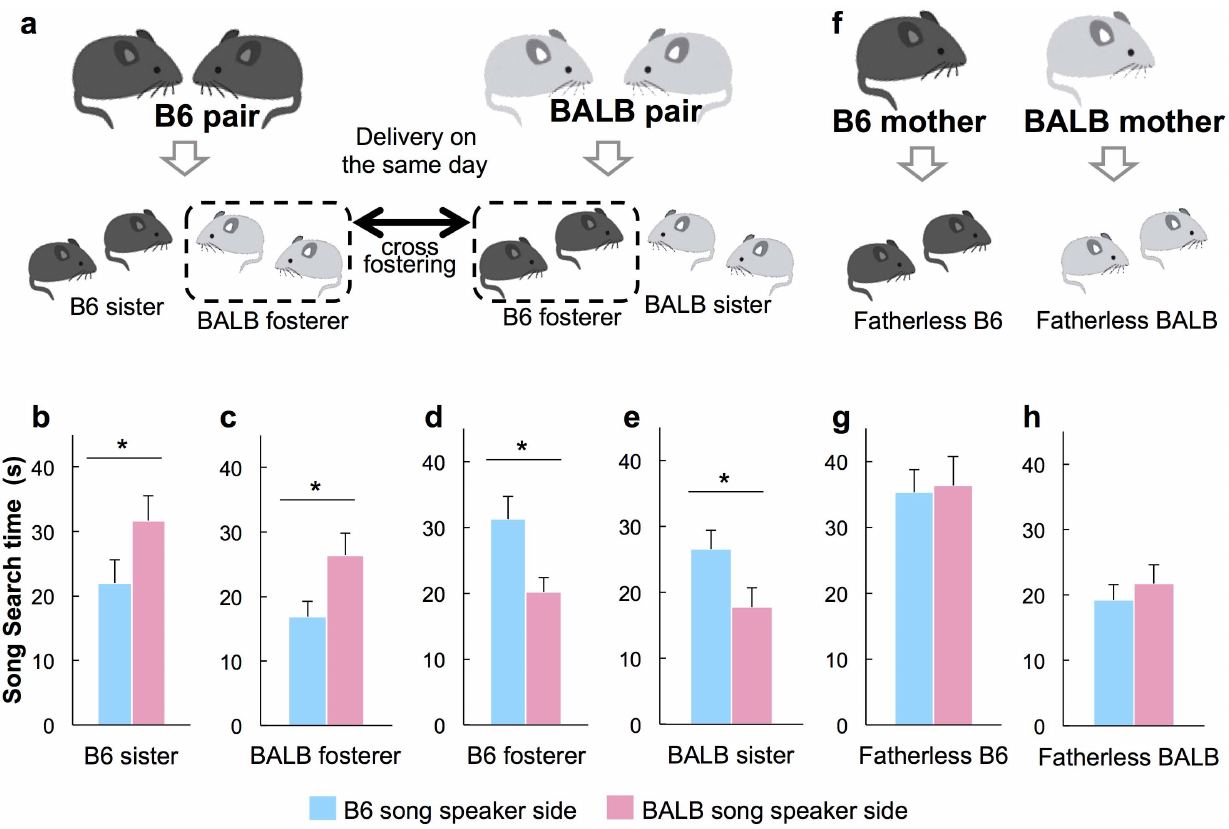
Figure 4. Cross-fostering reversed, and fatherless rearing diminished, female song preference. ( a ) Experimental scheme of the cross- fostering paradigm. Part of the litter (B6-fosterer and BALB-fosterer) was reciprocally cross-fostered to parents of the other strain of mice. ( b–e ) B6 sister ( n =10) and BALB-fosterer ( n =15) showed longer search times for BALB song. In contrast, B6-fosterer ( n =16) and BALB sister ( n =14) treated with ESP1 prior to the experiment showed longer search times for B6 song. GLM with fosterer/sister and male song as factors revealed significant effects of the interaction. ( f ) Fatherless B6 and fatherless BALB ware raised by mothers only. ( g–h ) There was no significant difference in search time for B6 and BALB songs in fatherless B6 and BALB females. Values represent means + standard error. Asterisks indicate significant differences p ,